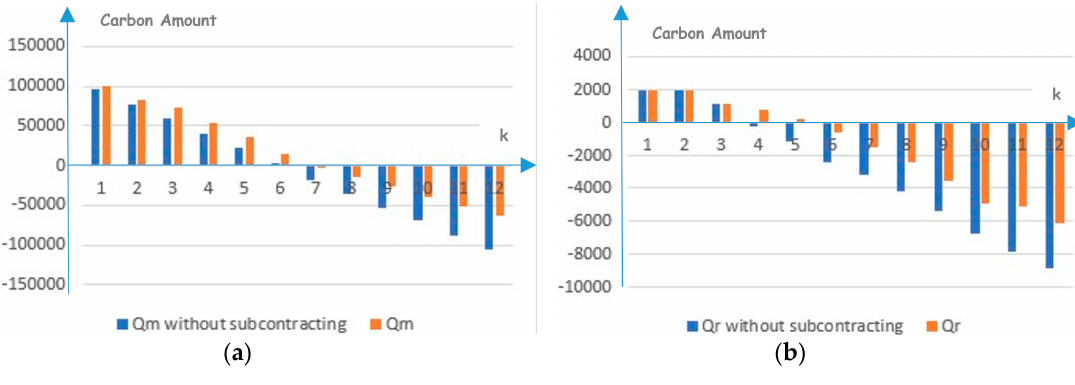
Figure 8. Amount of emitted carbon with and without subcontracting unit for C ps = 500; C c = 550. ( a ) Manufacturing unit; ( b ) Remanufacturing unit. Table 4. Production plan with C ps = 500; C c = 550.